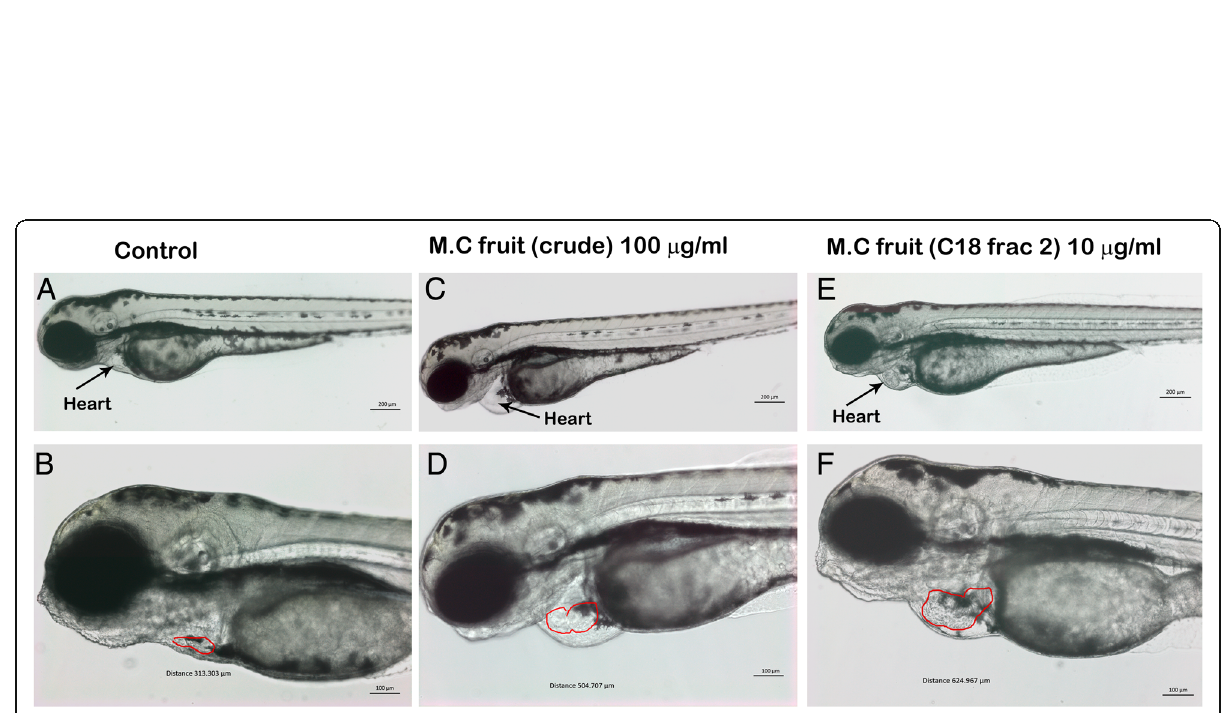
Fig. 3 Crude fruit extract of M. charantia induced cardiac hypertrophy in treated zebrafish embryos. Representative photomicrograph of live zebrafish embryos at 3dpf. a and b Mock (methanol 0.5% V/V) exposed embryos showed normal embryonic development and heart growth (black arrow). c and d the Zebrafish embryos treated with methanol fruit extract of M. charantia (100 μ g/ml). The treated embryos are not developmentally delayed as the protruding mouth structure which is prominent feature of zebrafish embryos at 72 hpf stage can also be seen clearly in treated embryos (arrow head). However, the treated embryos exhibited enlarged cardiac chamber (edema) and cardiac hypertrophy (arrow head). B and D are the higher magnification showing the heart of the same embryos presented in images A and C. The red encircled areas shows the areas which has been shown in μ m at the bottom of the image. e and f) Zebrafish embryos which were exposed to the fraction 2 (10 μ g/ml) obtained from the C18 column fractionation of ethyl acetate fraction of fruit extract of M. charantia . The treated embryos did not show developmental delay but had particular cardiac hypertrophy represented by black arrow. The area of the heart is almost 3X times bigger as compared to mock treated control embryos. Scale bar: 50 μ m